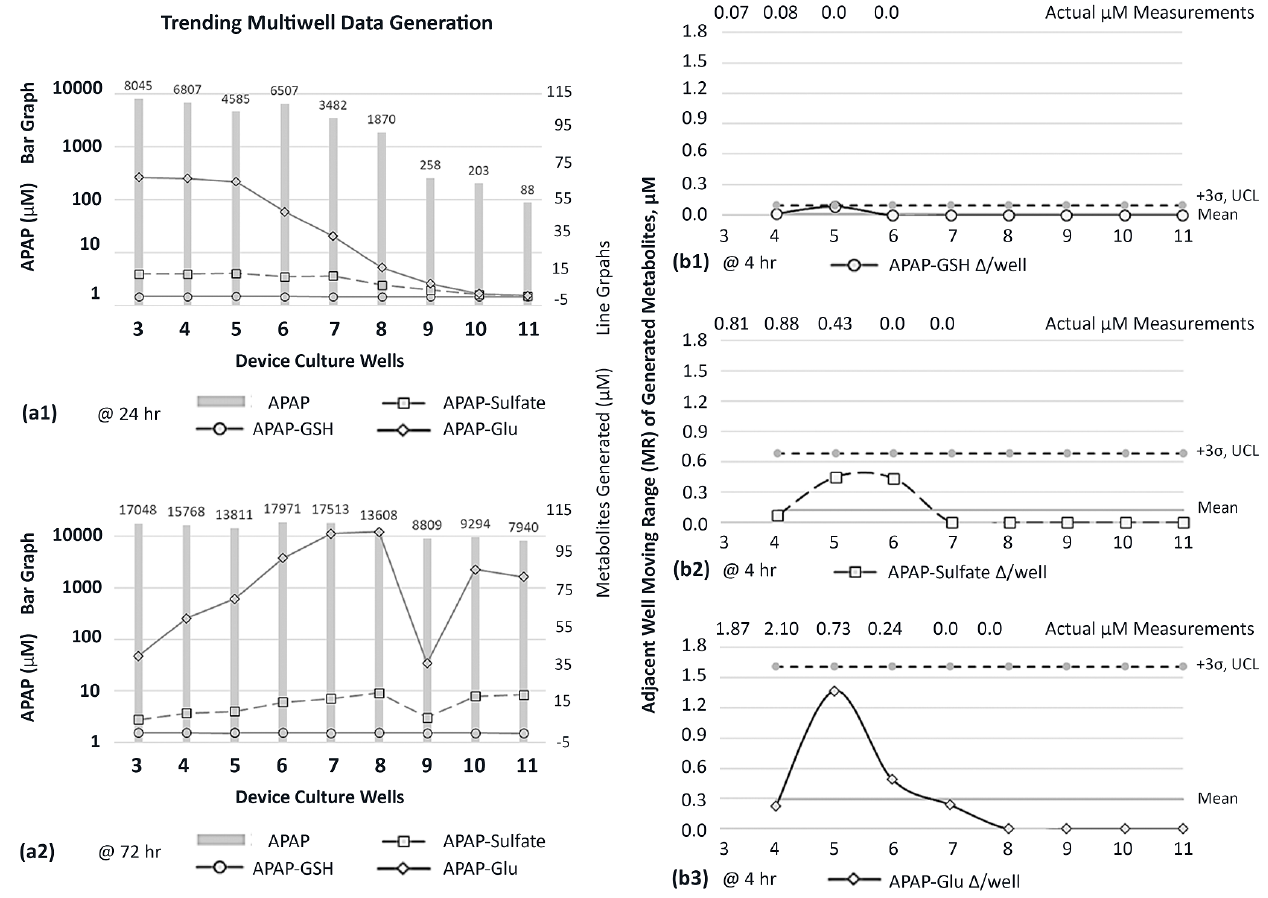
Figure 8. Trending channel evaluations for n = 1. ( a1 , a2 ) Concentration of APAP and cell-generated metabolites in each multiwell location, post compound dosing in the source well. x -axis is device culture wells 3–11, left vertical axis is APAP (logarithmic scale), right vertical axis is generated metabolites. ( a1 ) After 1 day, i.e., 24 h, and a single bolus dose in well 1. ( a2 ) After 3 days, i.e., 72 h, and daily dosing in well 1. ( b1 – b3 ) Origination of APAP metabolites across device multiwell locations 4–11, observed at 4 h after one APAP bolus dose into well 1. MR is the concentration change ( ∆ ) between adjacent wells. Well 3 is devoid of an upstream adjoining well (i.e., cellular) and precludes calculation. The APAP metabolite variances ( ∆ /well) are ( b1 ) APAP-GSH, ( b2 ) APAP-sulfate, and ( b3 )